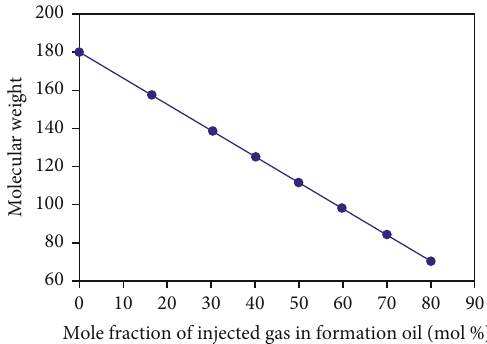
Figure 6: Curve of molecular weight versus CO